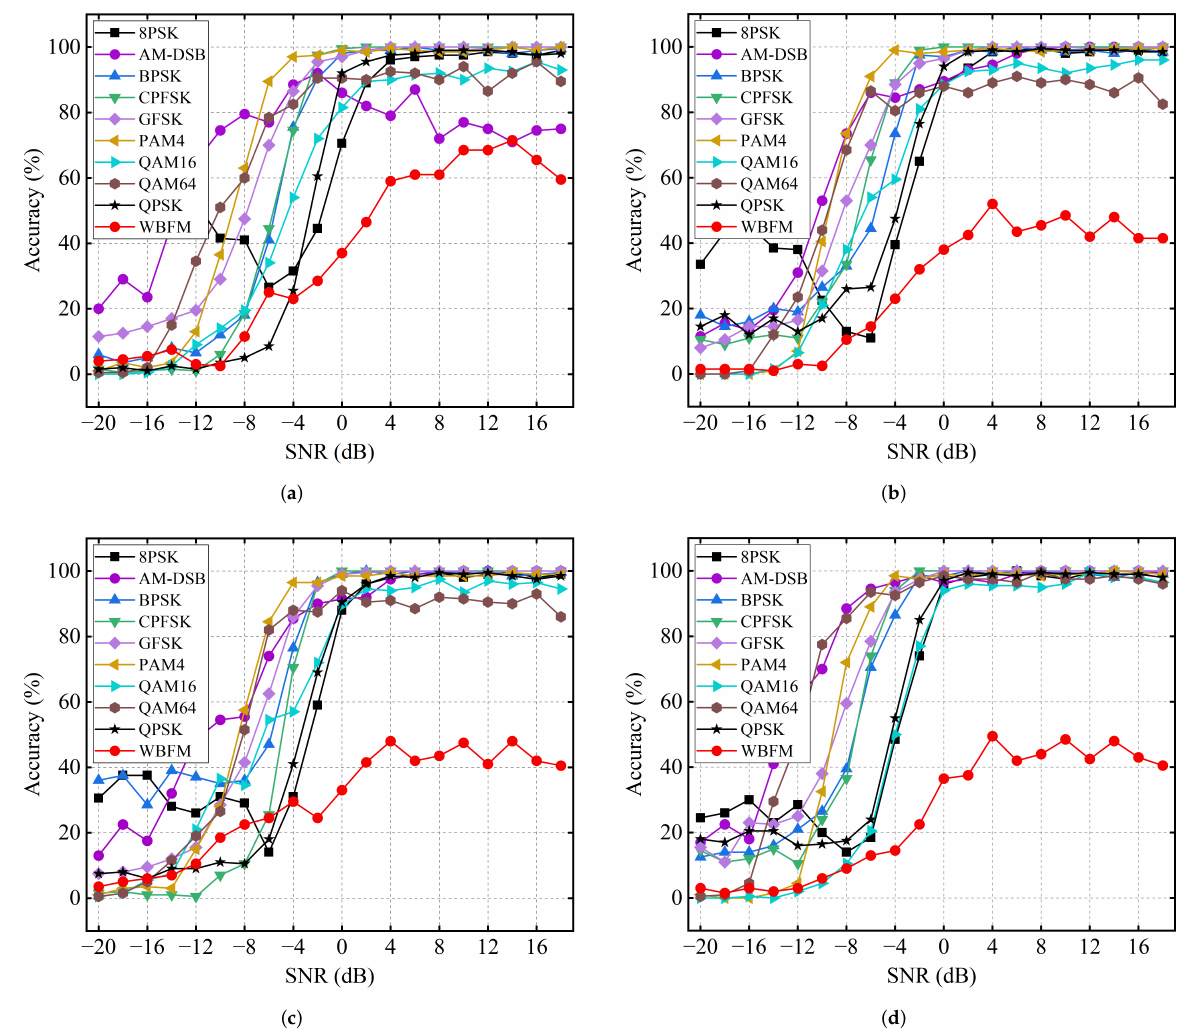
Figure 7. Classification accuracy at each SNR and modulation type of ( a ) DAE, ( b ) LENet-T, ( c ) LSTM2, and ( d ) LENet-M on the 2016A